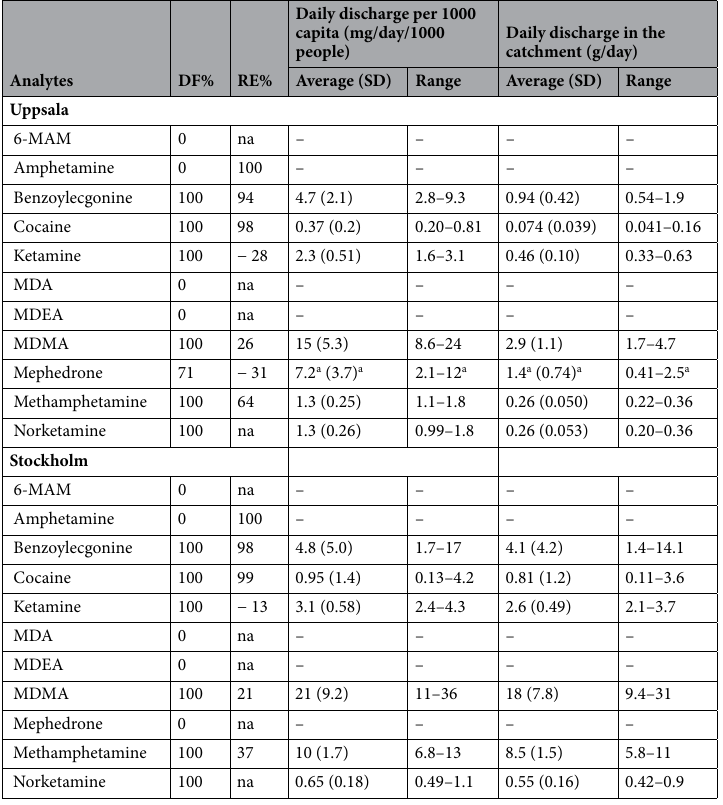
Table 5. Detection frequency (DF%), removal efficiency (RE%), and daily discharge in the effluent wastewater from Uppsala and Stockholm WWTPs. –: not provided due to DF 0% in effluent wastewater; na: not available as the analyte was not quantifiable in influent and/or effluent wastewaters; SD: standard deviation. a Quantifiable only in samples from Thursday to